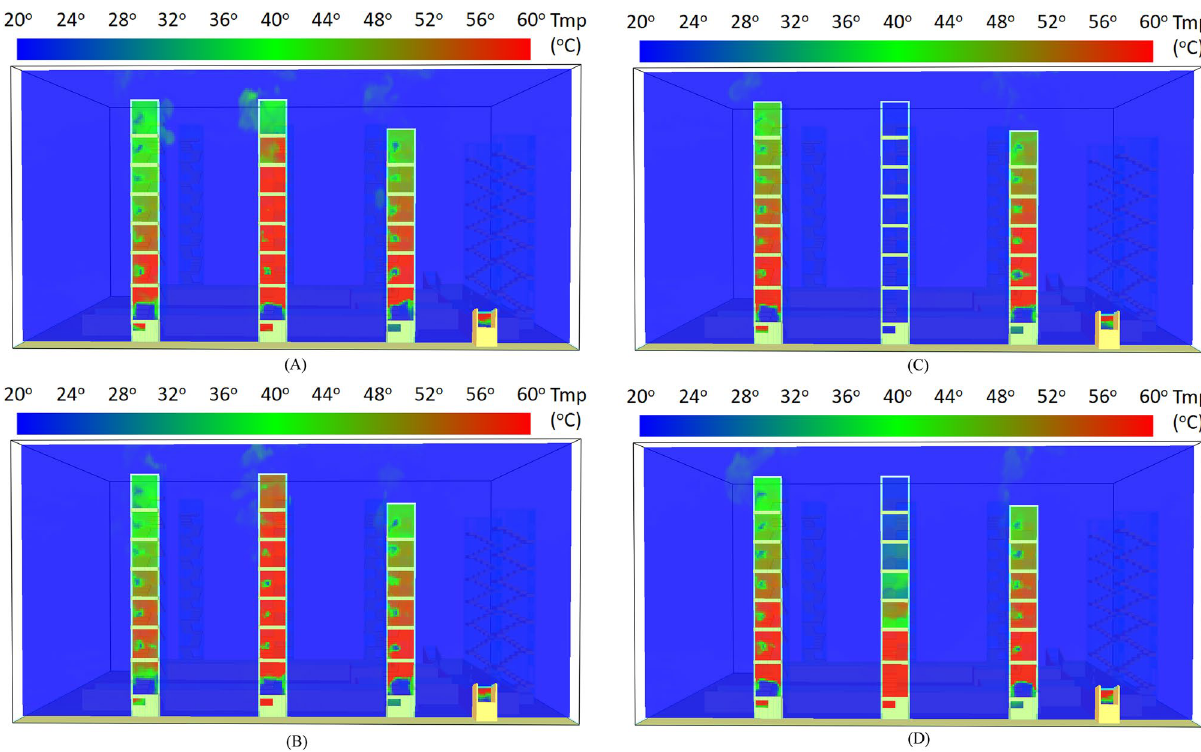
Figure 20. Temperature diffusion inside the 1st, 2nd and 3rd stairs of buildings for each case at 600 s ( A ) Case Tc_Wtc_B1o. ( B ) Case To_WAo_B1o. ( C ) Case Tc_Wtc_B1c. ( D ) Case